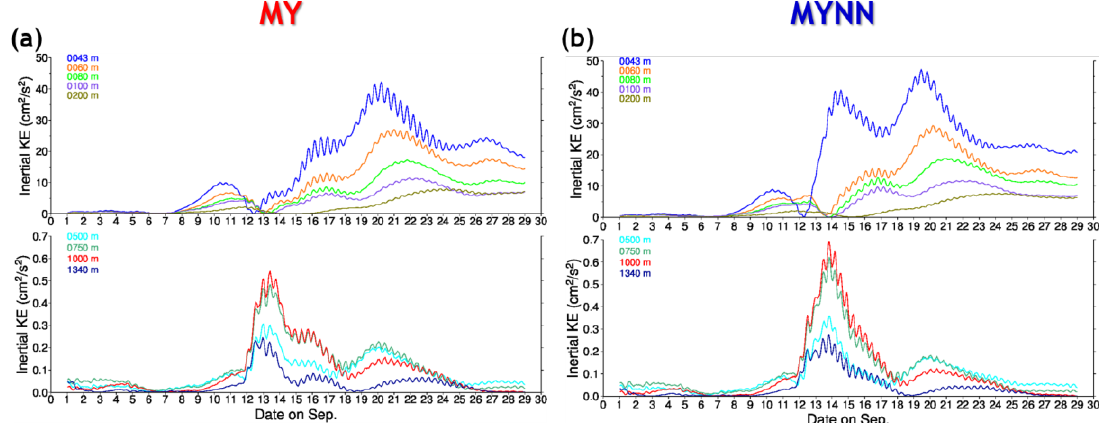
Figure 9. Time evolutions of the near-inertial kinetic energy simulated using ( a ) the Mellor–Yamada (MY) and ( b ) the Mellor–Yamada–Nakanishi–Niino (MYNN) models at several depths at a point of 133 ◦ 40.7 (cid:48) E, 38 ◦ 40.0 (cid:48) N. The top row in each panel is the upper layer ( < 200 m depth), and the bottom row in each panel is the lower layer ( > 500 m depth).